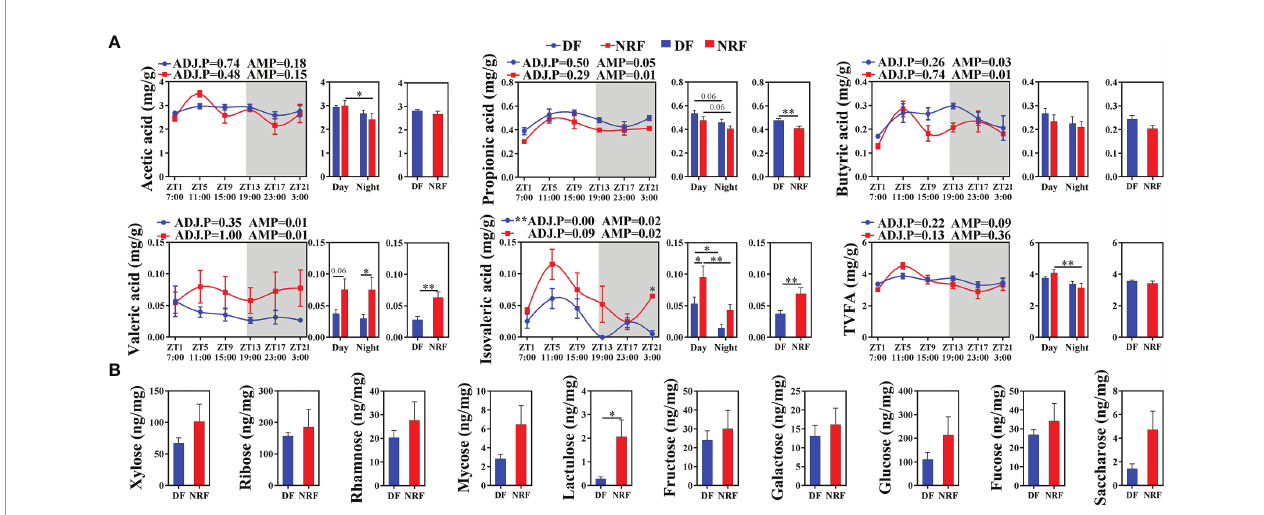
FIGURE 4 | Effects of feeding time on the metabolites of cecal microbiome in growing rabbits. (A) Effects of feeding time on the concentration of short-chain fatty acids in cecum (n = 6 per time point). White boxes indicate daytime and gray boxes indicate nighttime. ADJ.P for adjusted minimal p -values, ADJ.P < 0.05 indicates signi fi cant diurnal rhythm, AMP represents amplitude, *ADJ.P < 0.05; **ADJ.P < 0.01. (B) Effects of feeding time on sugar metabolites in cecum (n = 6). Differences between the DF and NRF groups were determined with a t-test, * p < 0.05. Data are shown as the mean ± SEM. DF, daytime feeding; NRF, night-restricted feeding.